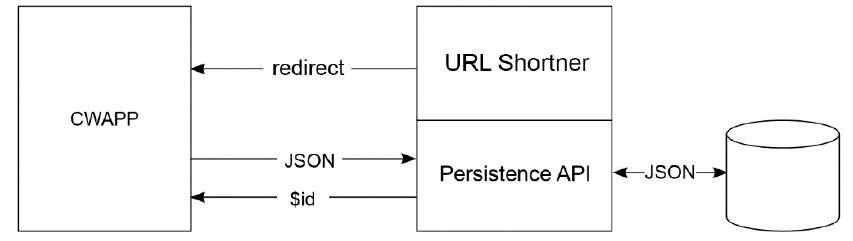
Figure 8. CWLY application flow diagram. Source: adapted from [10].